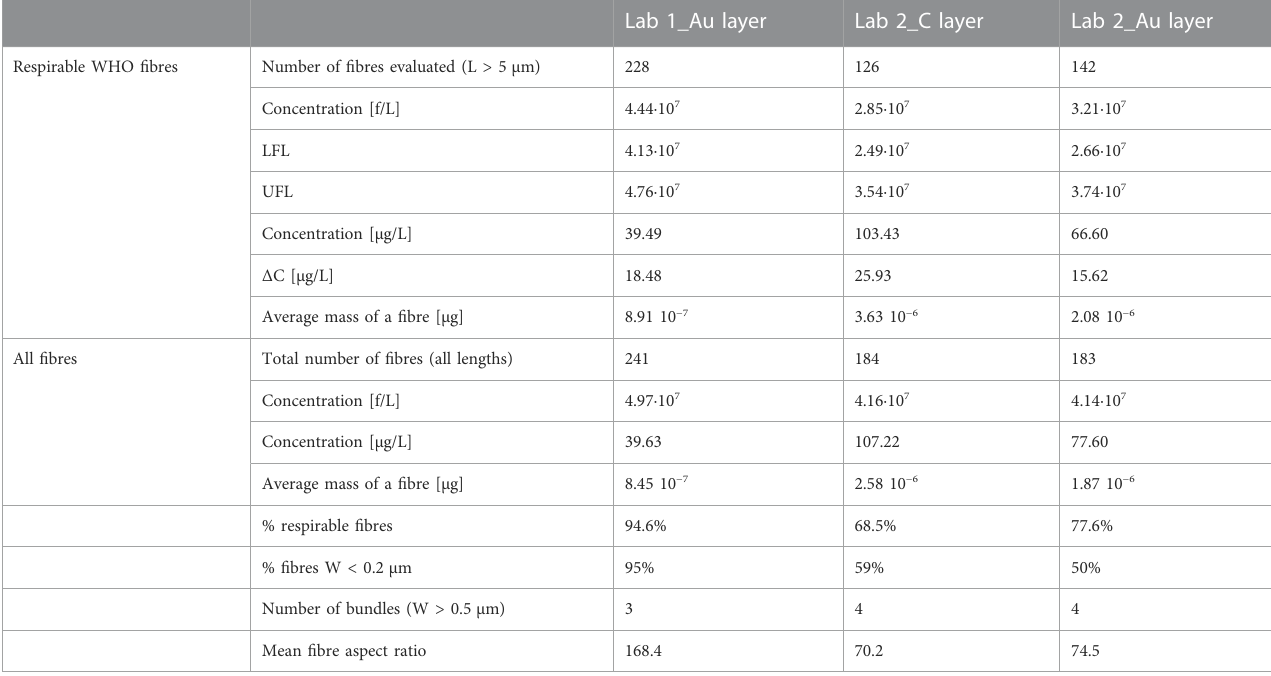
TABLE2Experimental dataobtainedonthesample, usingdifferentsetups.Thecon fi dencelimits(LFL-UFLand Δ C)werecalculatedonlyfor therespirable fi brescount, following the methodologies reported in the text.